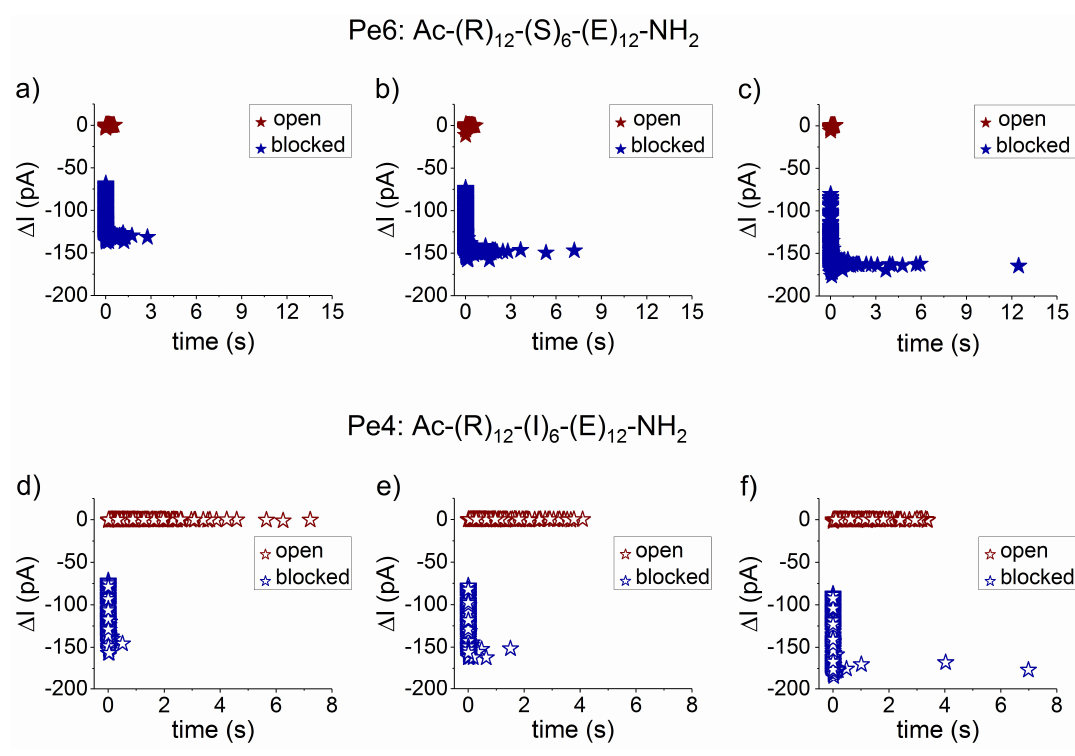
Figure 2. Scatter plots of dwell time vs. blockade amplitude ( ∆ I ) of peptides-induced reversible obstructions of the ionic current through the α -HL nanopore. We display the scatter plot analysis corresponding to the Pe6 peptide interacting reversibly with the nanopore from the trans side, at distinct voltages: ∆ V = +80 mV ( a ); ∆ V = +90 mV ( b ); and ∆ V = +100 mV ( c ). We present the scatter plot analysis of Pe4- α -HL interactions, at similar representative voltages: ∆ V = +80 mV ( d ); ∆ V = +90 mV ( e ); and ∆ V = +100 mV ( f ). Distinctly drawn are the events corresponding to the open (red stars) and blocked sub-states (blue